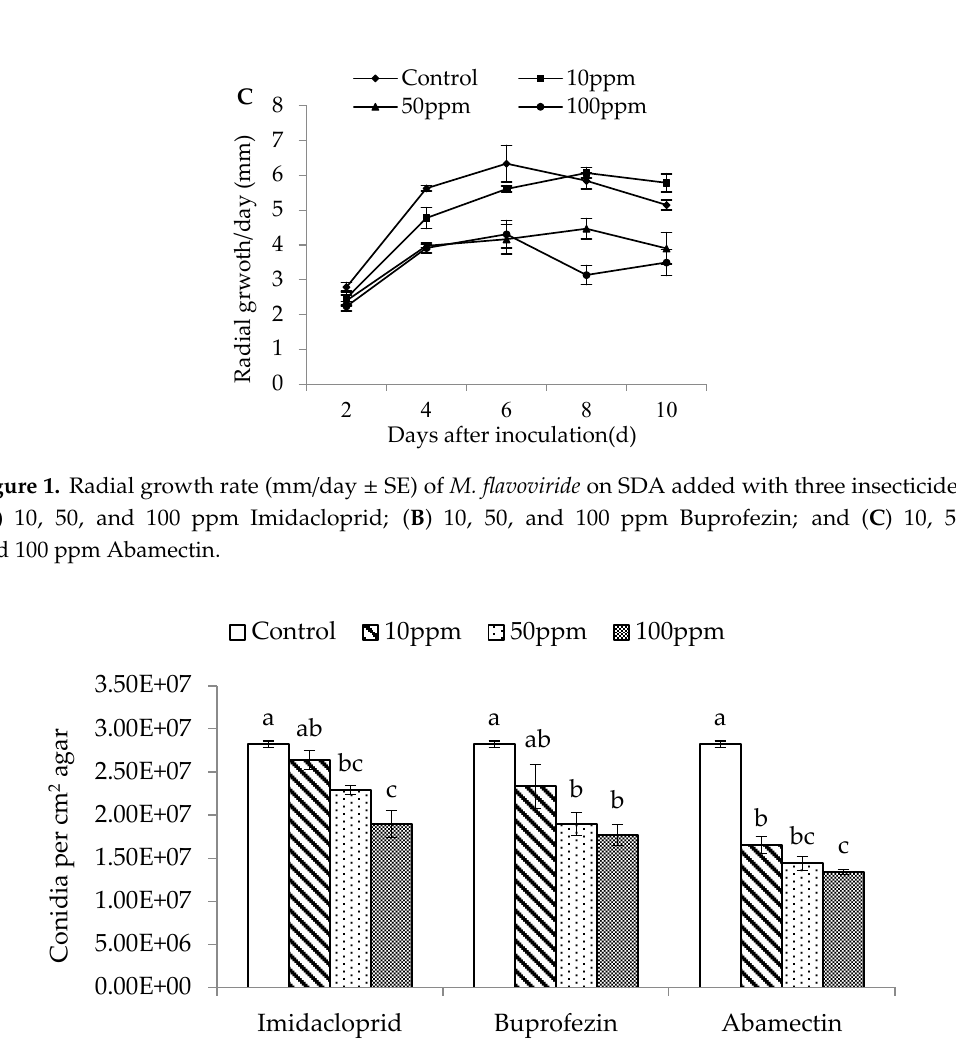
Figure 2. Mean ( ± SE) conidia production per cm 2 on SDA with added insecticides Imidacloprid, Buprofezin, and Abamectin at 10, 50, and 100 ppm. The same letters above the bar indicate no significant difference (Tukey’s HSD at p = 0.05).